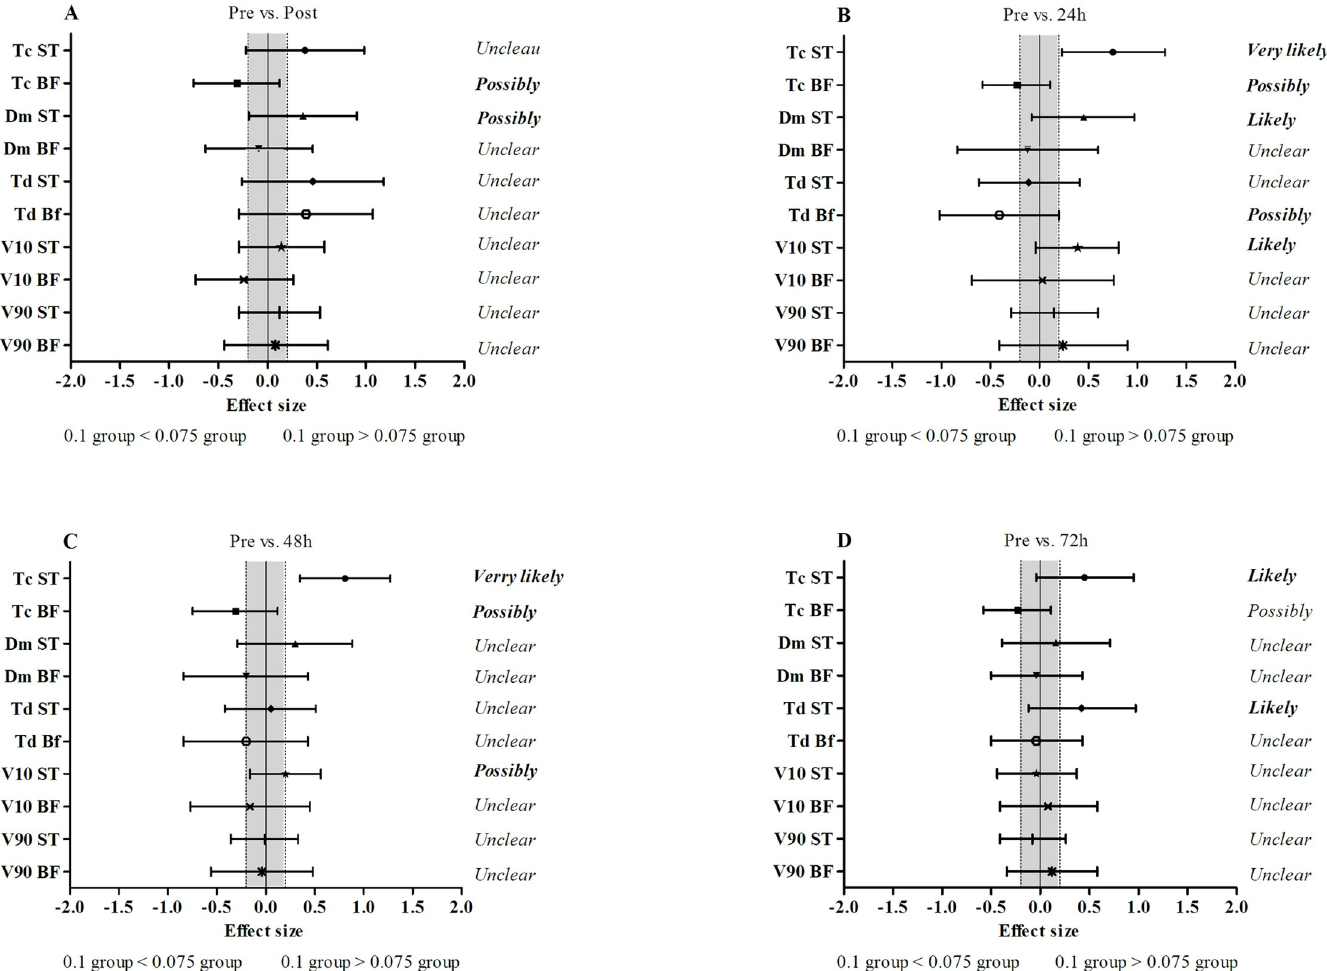
Fig 5. Standardized difference (effect size) between 0.01 and 0.075 groups in the muscle contractile proprieties changes immediately, 24h, 48h and 72h after iso- inertial exercise. Panel A: Pre- vs. Post; Panel B: Pre- vs 24h; Panel C: Pre- vs. 48h; Panel D: Pre- vs. 72h. Bars are 90% confidence interval. Grey area represents the smallest worthwhile difference (0.2 based on Cohen’s principle). ST: semitendinosus muscle; BF: biceps femoris muscle. Tc: contraction time; Dm: maximal radial displacement of the muscle belly; Td: delay time; V 10 : muscle contraction velocity at 10% Dm; V 90 : muscle contraction velocity at 90%